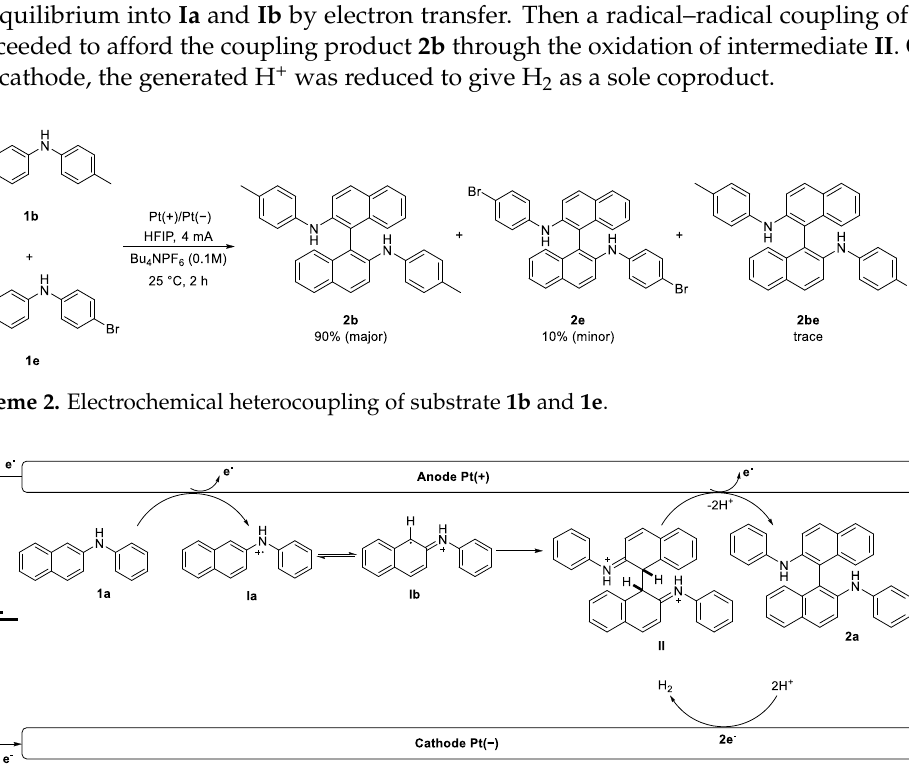
Table S1. Screening solvent of constant current for optimizing reaction conditions; Figure S2: